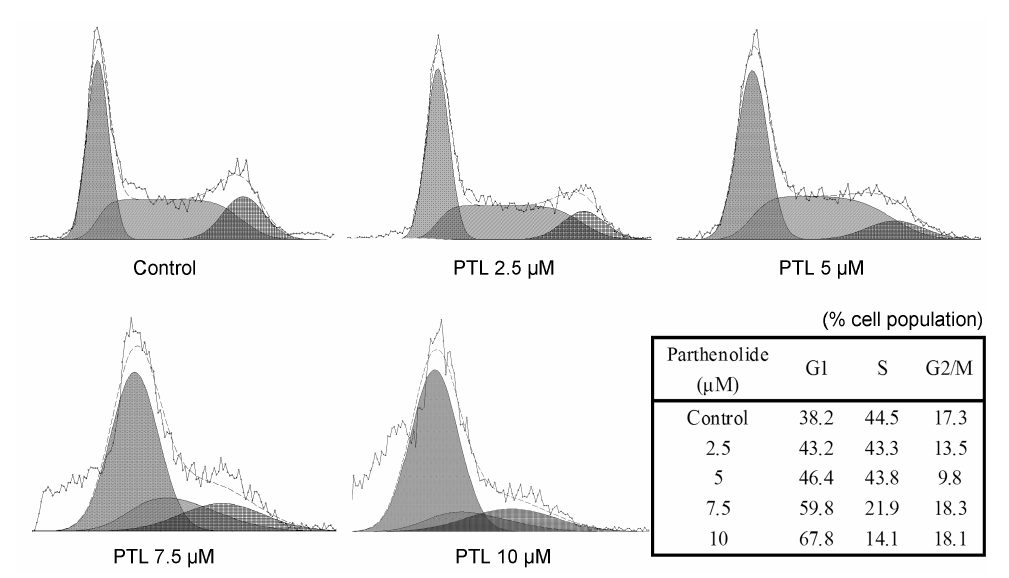
Figure 4. Cell cycle analysis of 5637 bladder cancer cells treated with parthenolide. Cells were cultured with different concentrations of parthenolide for 24 h and then stained with propidium iodide. The DNA content was analyzed by flow cytometry. G1, S, and G2/M indicate cell cycle